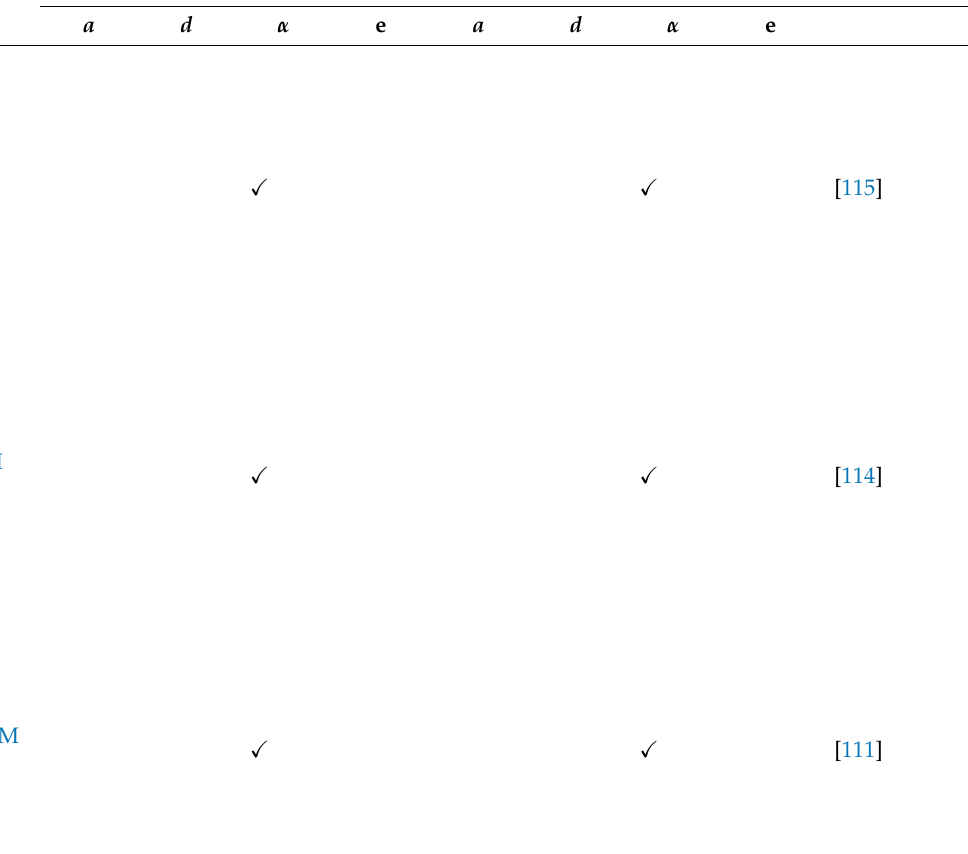
Table 5. Transcriptome-wide association studies (TWAS) and longitudinal-related LMMS models, software, and packages for GWAS.